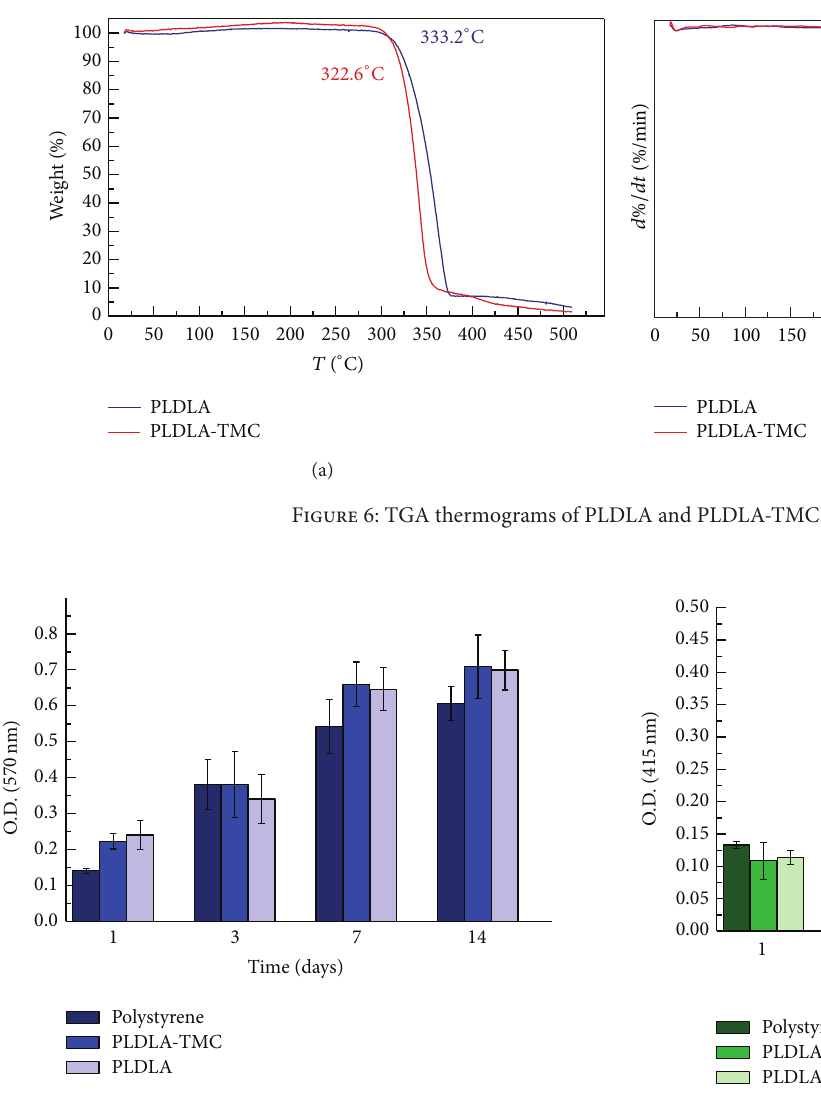
Figure 7: Viability of SaOS-2 osteoblasts grown on scaffolds. The values are the mean ± SD ( 𝑛 = 6 ).